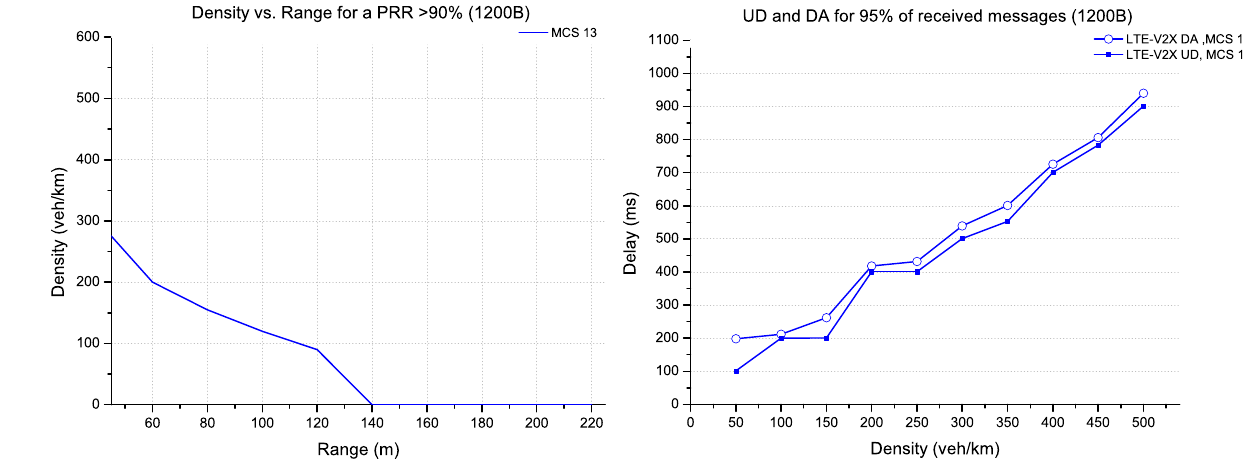
Figure 10. Evaluation for LTE-V2X technology (packet size 1200 bytes).